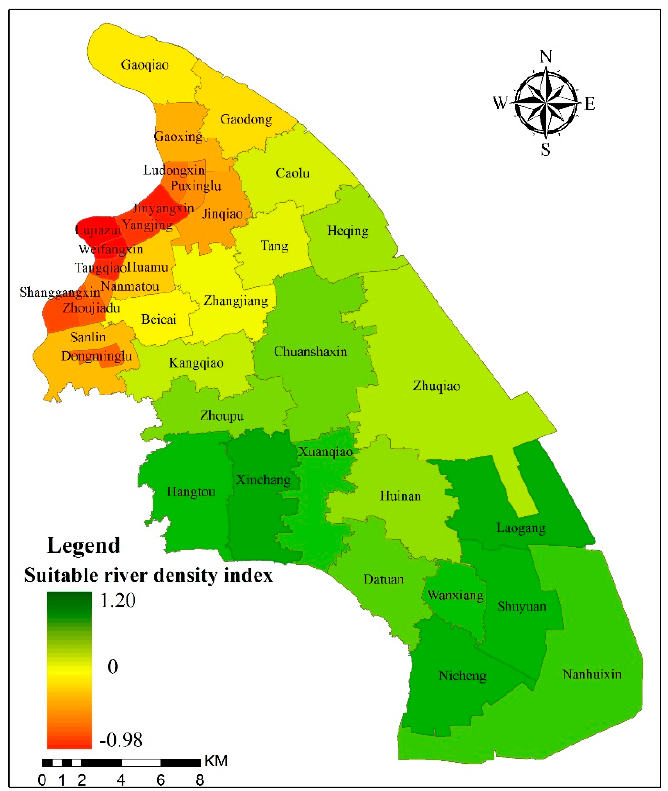
Figure 6. Suitable river density index of the Pudong New Area. Table 2. Suitable river network structure of the Pudong New Area.